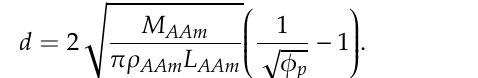
Figure 6. Mean water thickness of PAAm hydrogels with different water content.